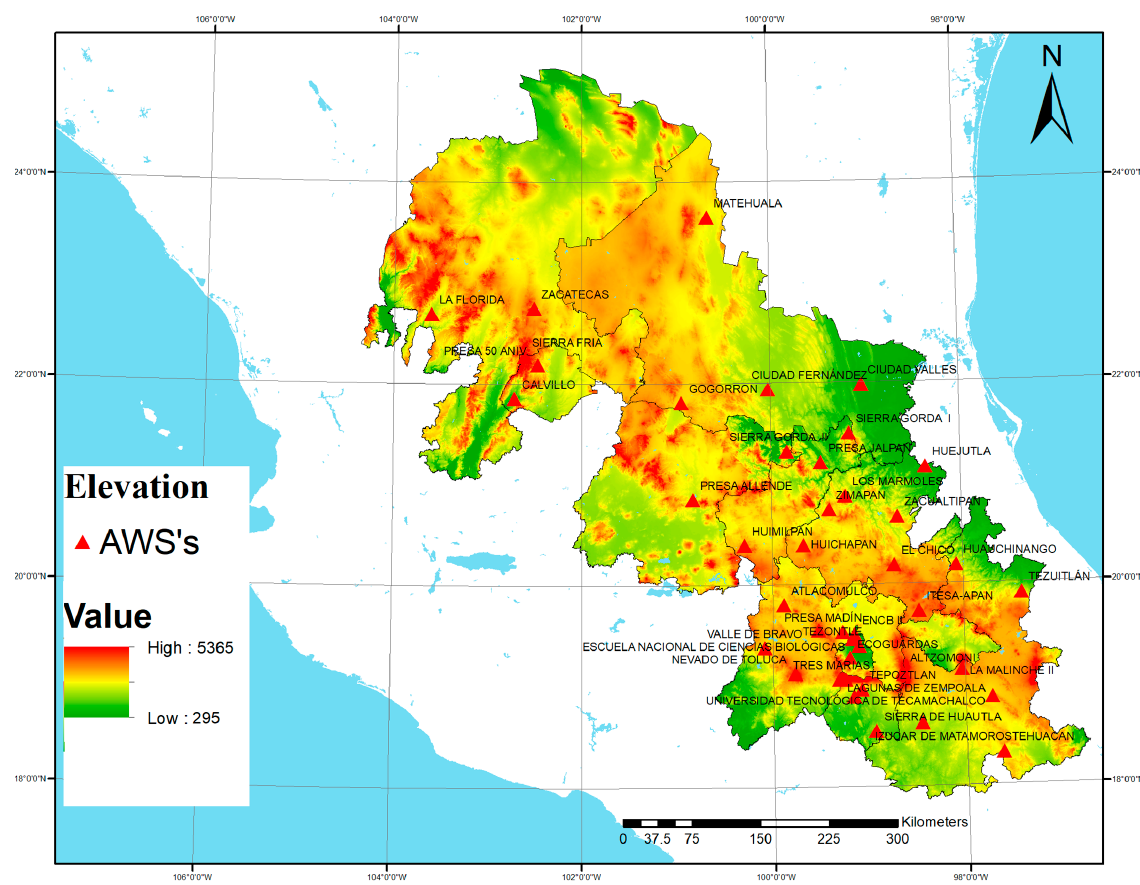
Figure 7. Central Mexico elevation map.